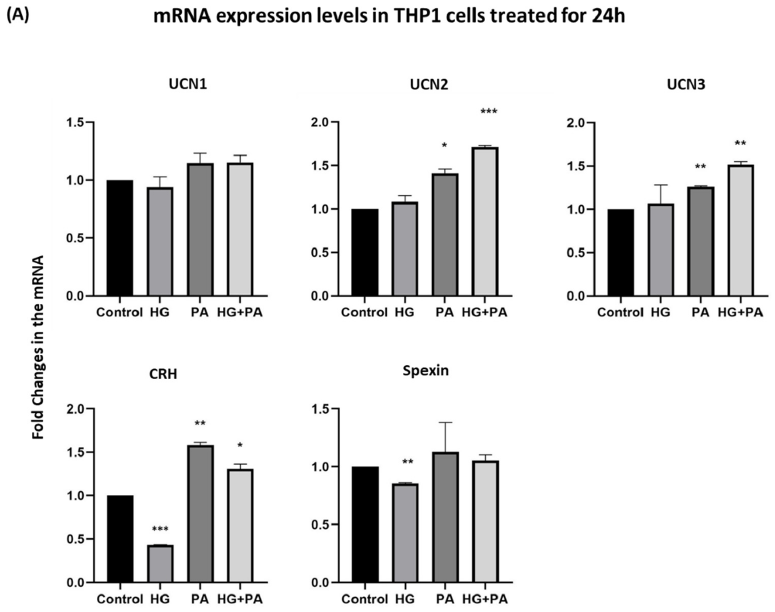
Figure 2. Gene expression in THP1 cells treated for four hours. mRNA expression levels of UCN1, UCN2, UCN3, CRH, and spexin were measured by quantitative real-time PCR in THP1 cells treated with high glucose (25 mM), palmitate (200 µM) or the combination for 4 h ( n = 3 for each condition). Data are normalized to internal GAPDH and presented as fold-change compared with control data. One-way ANOVA with repeated measurements followed by Sidak´s post hoc test were used to determine the significance of the differences in means between the groups (* p < 0.05, ** p < 0.01, *** p < 0.001).